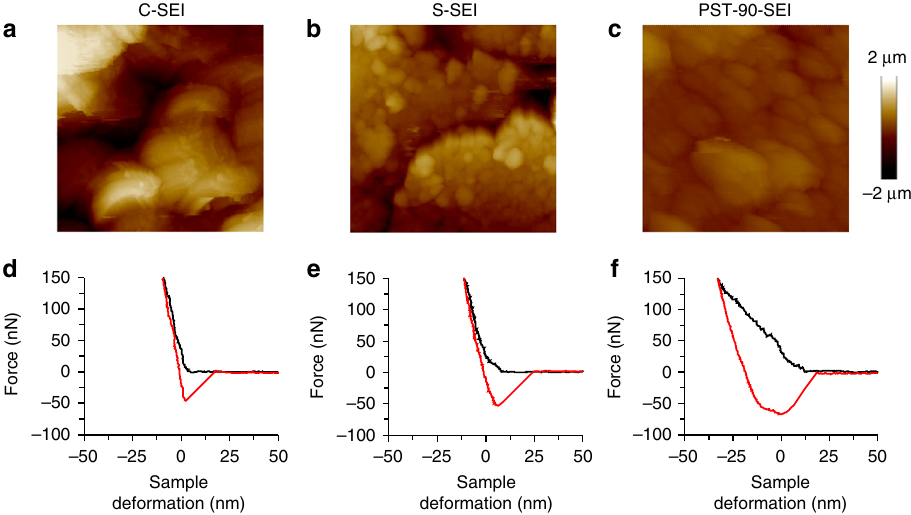
Fig. 4 Surface morphology and mechanical property of the SEI layers formed from the different electrolytes. AFM images (10 × 10 µ m 2 scan size) of the C-SEI layer ( a ), S-SEI layer ( b ), and PST-90-SEI layer ( c ). Indentation curves of the C-SEI layer ( d ), S-SEI layer ( e ), and PST-90-SEI layer ( f ). The SEI layers were obtained after 100 cycles of Li plating/stripping, and Li was stripped completely before the AFM